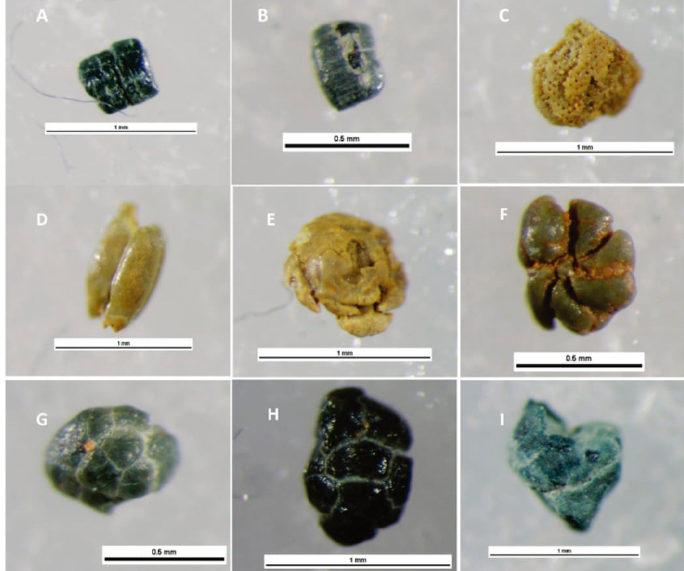
Figure 1. Binocular microscope images of grains of glaucony including: ( A ) Medium-dark green vermicular glaucony from Campbell’s Beach (Gee greensand), ( B ) dark green vermicular glaucony from Earthquakes (Kokoamu greensand), ( C ) well preserved pale green glaucony derived from echinoderm host grain—Gee’s Beach (Gee greensand), ( D – F ) pale green growth inside benthic foraminifera (Gee’s Beach), ( G ) glaucony from Earthquakes (Kokoamu greensand), ( H ) glaucony and the Waipara (Waipara greensand), and ( I ) amorphous grain, possibly derived from lithic material (Waipara).